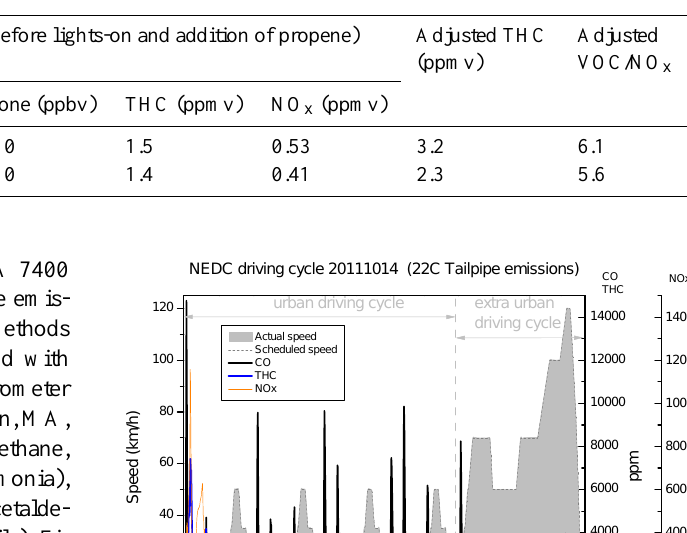
ated butanol (butanol-D9, 98 % Aldritch) was injected